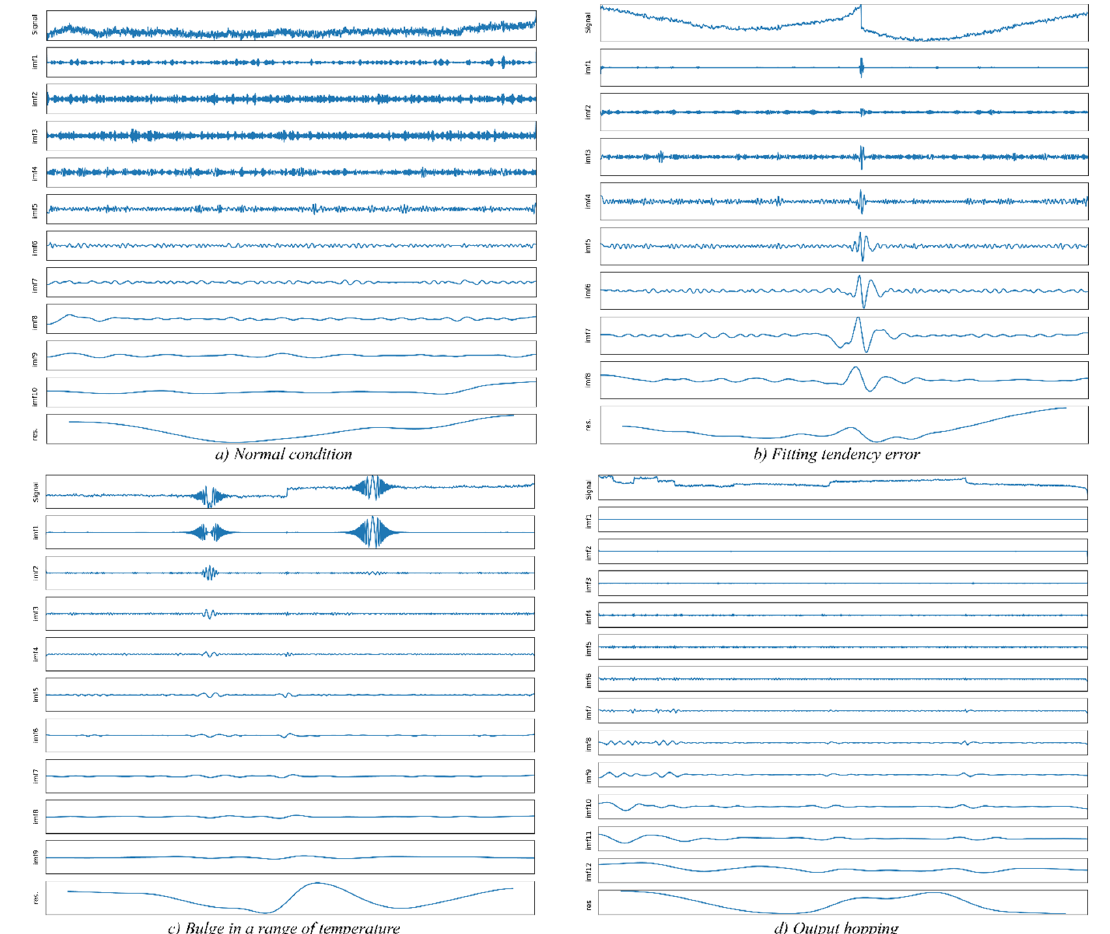
Figure 11. EMD results using proposed BLSTM-based EMD. ( a ) EMD result in case of normal condition; ( b ) EMD result in case of fitting error fault occurs; ( c ) EMD result in case of bulge in a range of temperature fault occurs; ( d ) EMD result in case of output hopping error fault occurs.